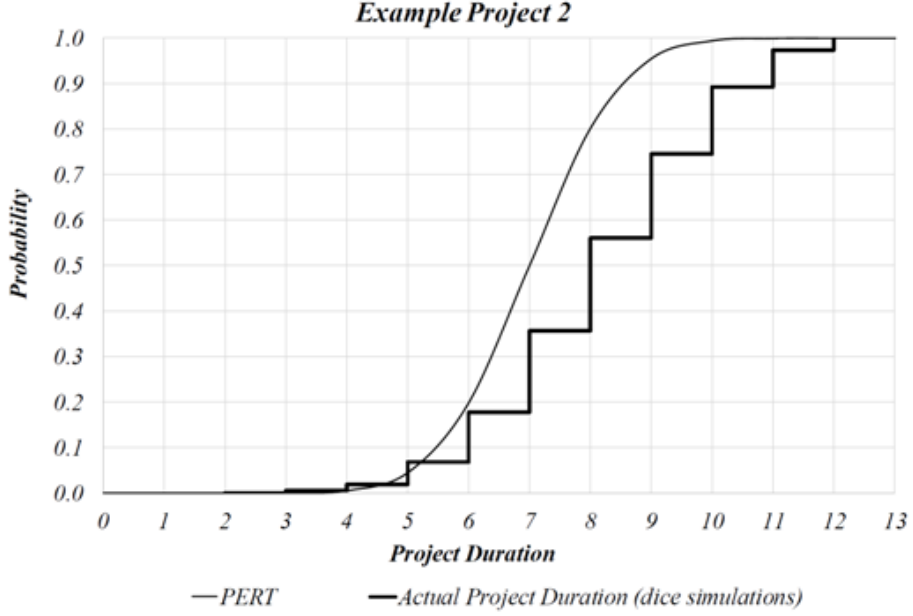
Figure 8. PERT project duration estimation versus the Actual one for Example Project